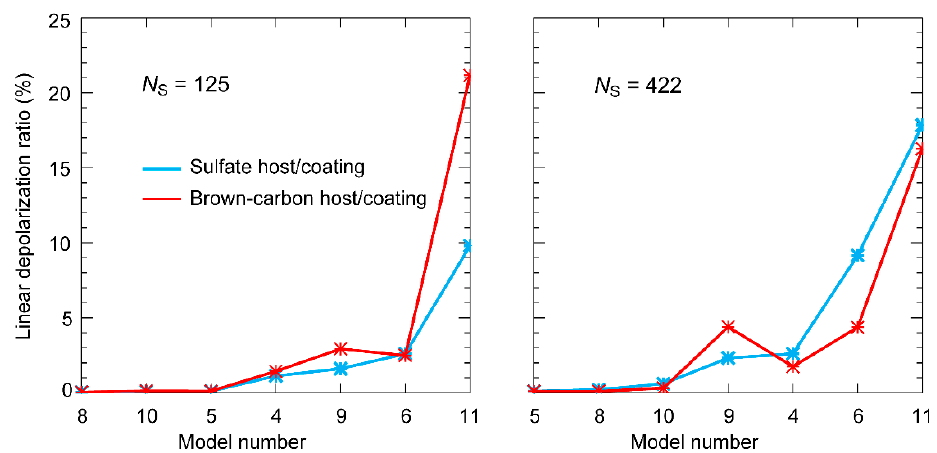
Figure 11. LDR differences at λ = 532 nm between soot-containing aerosols hosted/coated by sulfate (blue lines) and brown-carbon (red lines) materials. The soot volume fraction is fixed at f = 7%. The number of soot spherules is N S = 125 (left-hand panel) and 422 (right-hand panel).